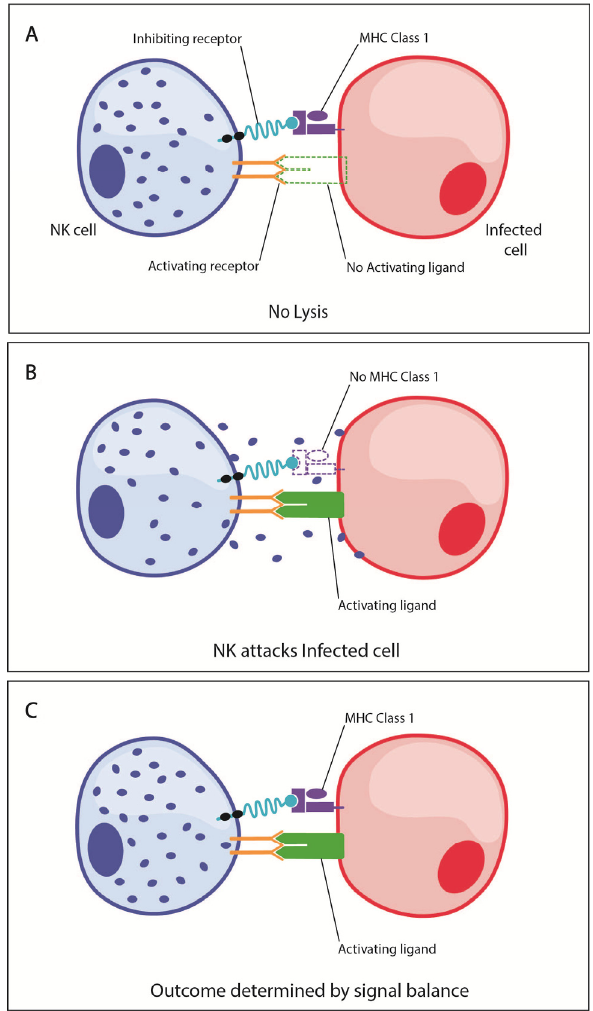
Figure 1. Natural killer (NK) cell activating and inhibitory signaling mediates phenotypic outcomes. ( A ) When NK cell inhibitory receptors bind MHC class I on the target cell, this interaction suppresses NK cell activation and lysis of the target cell. ( B ) In some circumstances, the activating receptor on NK cells will bind the activating ligand on the target cell, while the inhibitory receptor does not bind MHC Class I, leading to NK cell activation and lysis of the target cell. ( C ) When the target cell expresses both MHC Class I and activating ligands, the fate of the target cell is determined by a balance of signals.